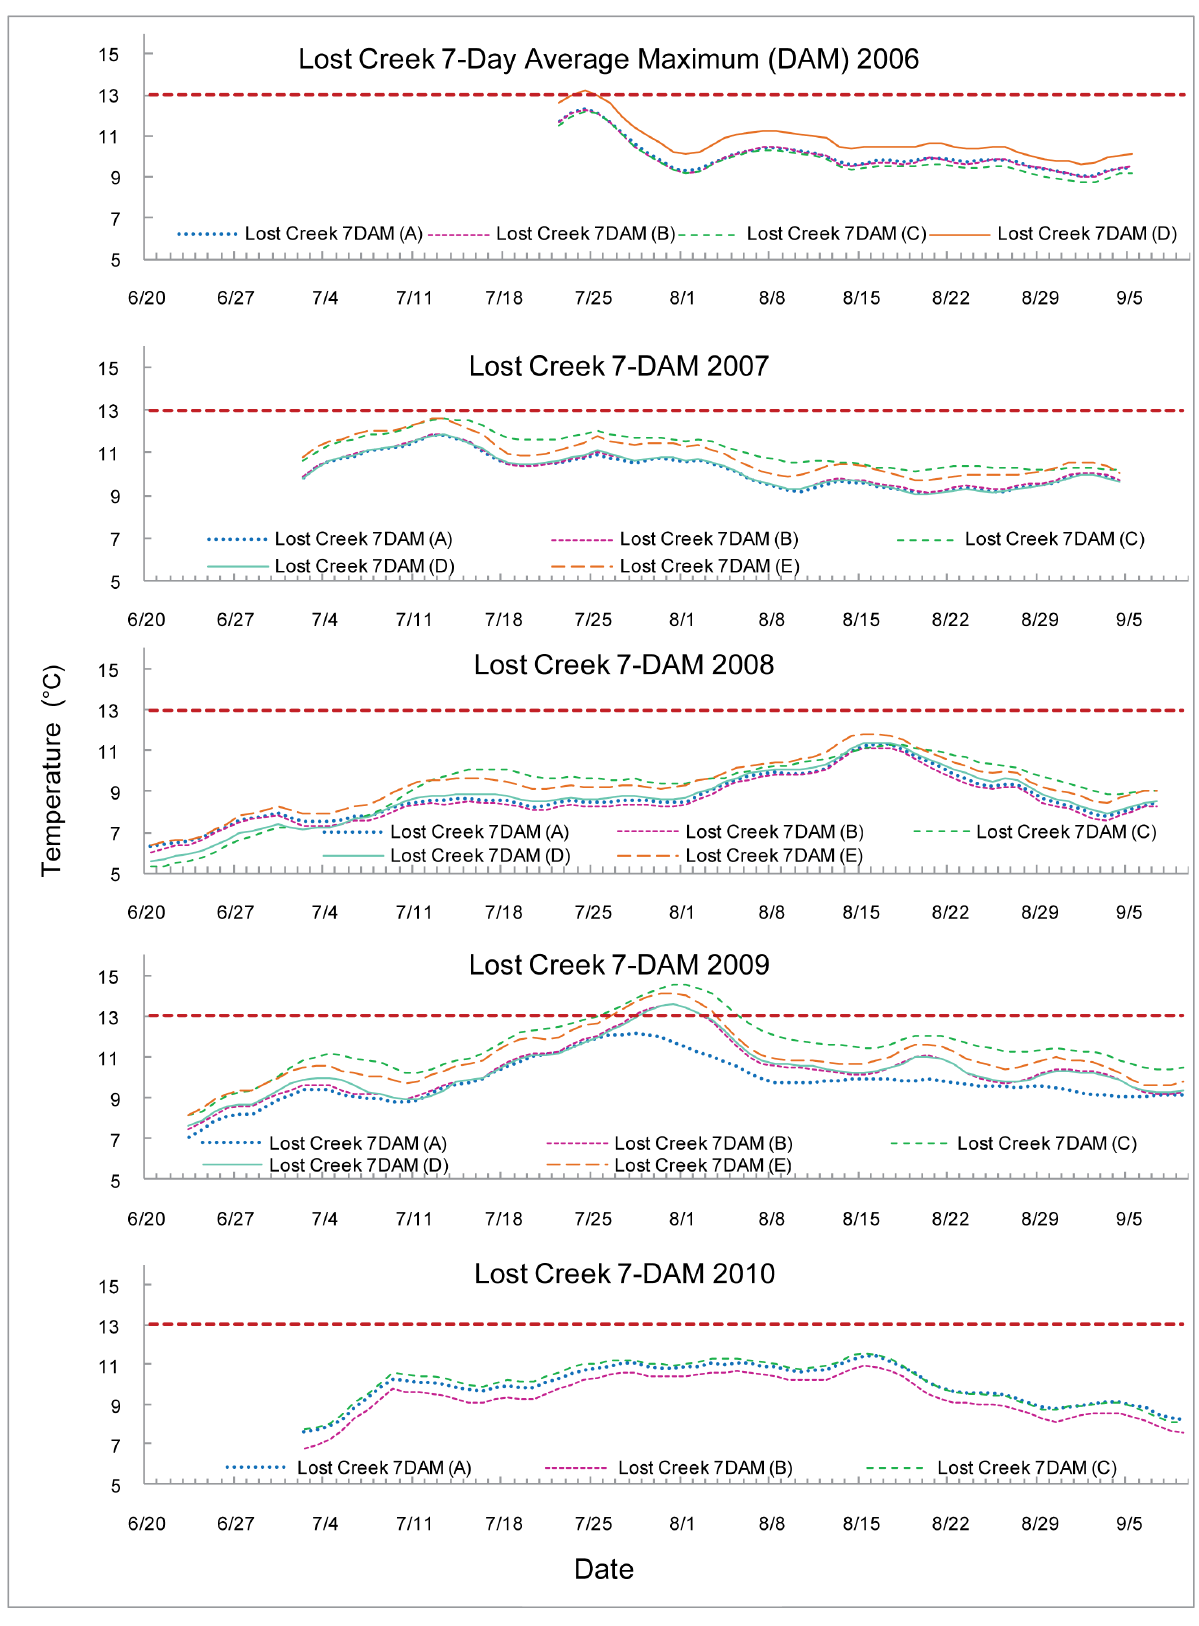
Figure 3. 7-Day average maximum (7-DAM) temperatures of Lost Creek.